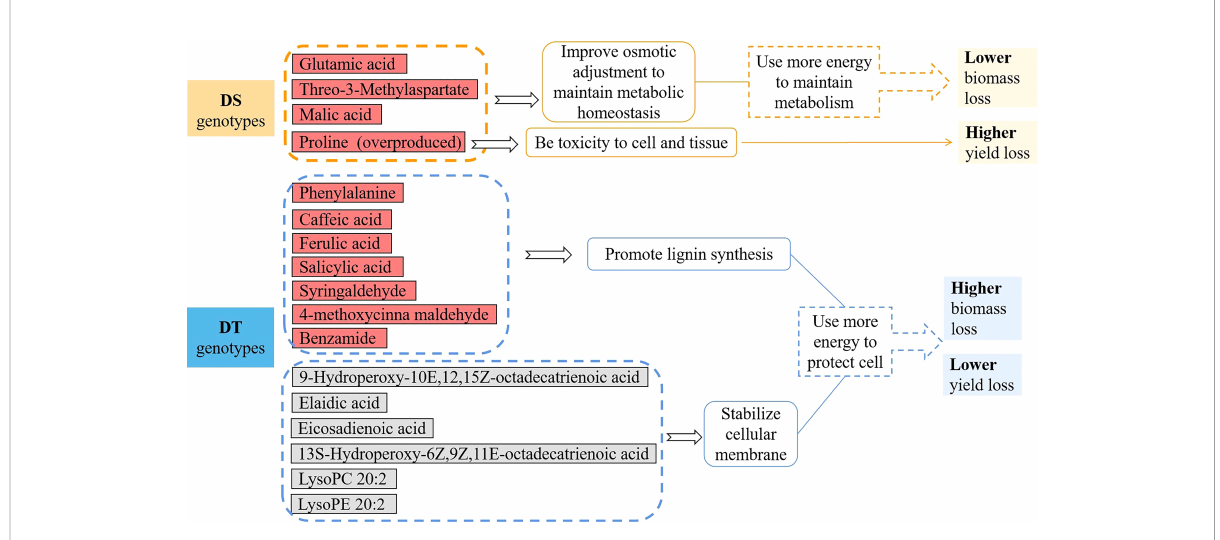
FIGURE 6 The differences of biomass loss, yield loss and metabolites between the drought tolerant (DT) dryland genotypes and drought sensitive (DS) irrigated genotypes under severer drought stress. In metabolic differences, the red color represents signi fi cant increase and gray color represents no signi fi cant change (p < 0.05) under severer drought